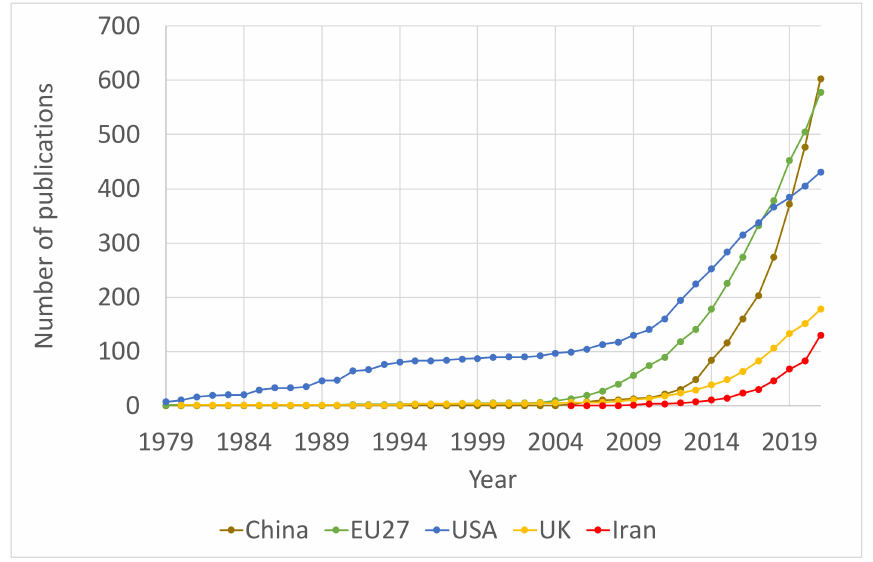
Figure 8. Top countries/territories publishing on